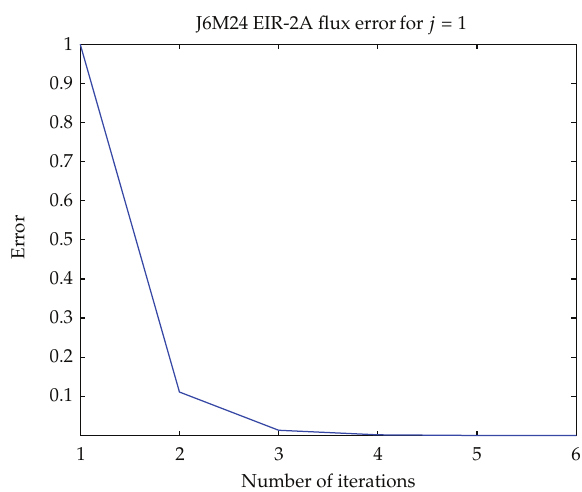
Figure 15: Cauchy error in flux convergence for J6M24 EIR